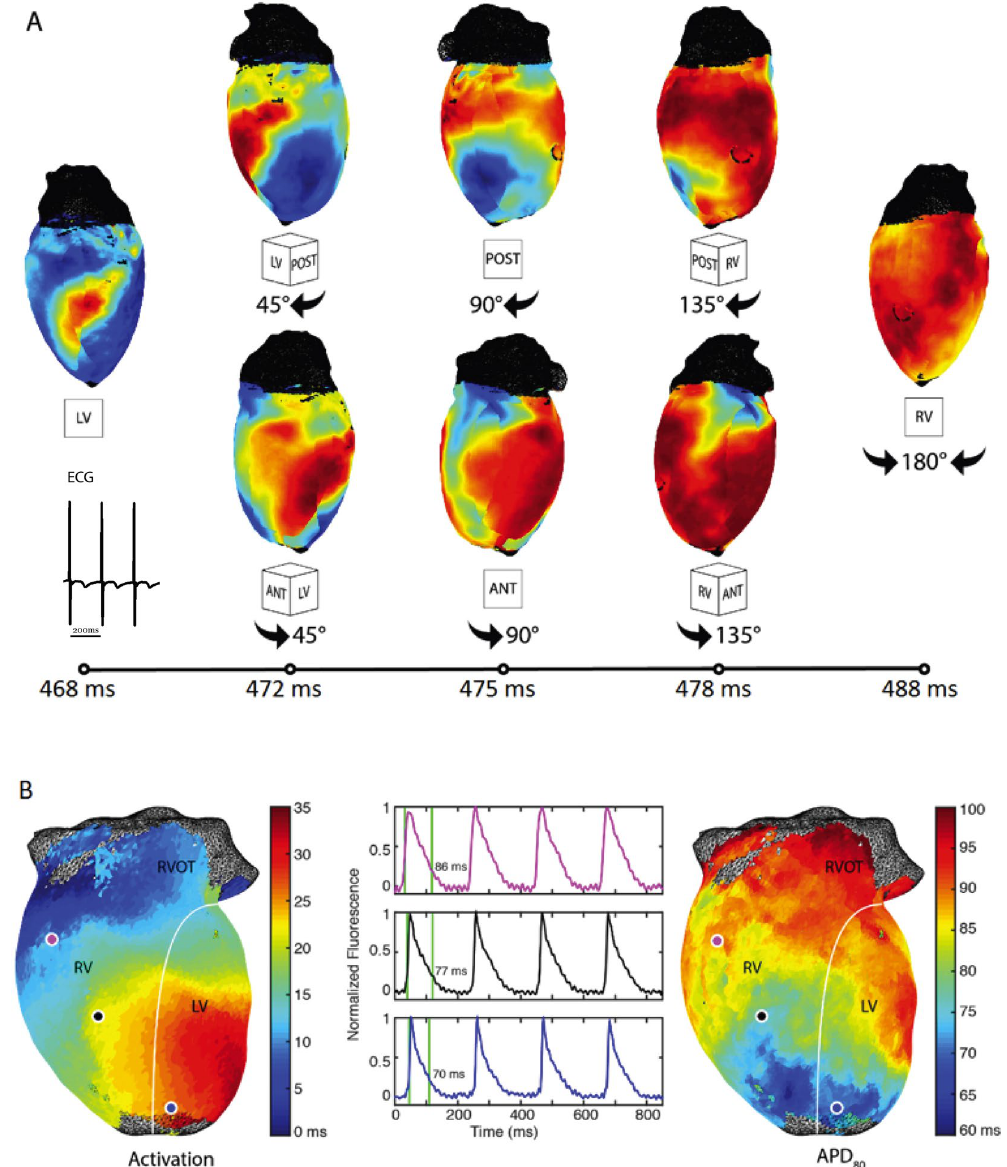
Figure 7. Representative rat panoramic optical data. ( A ) The time course of pacing activation is tracked using membrane potential. ( B ) Activation and the corresponding action potential duration (APD80) maps are seen along with representative action